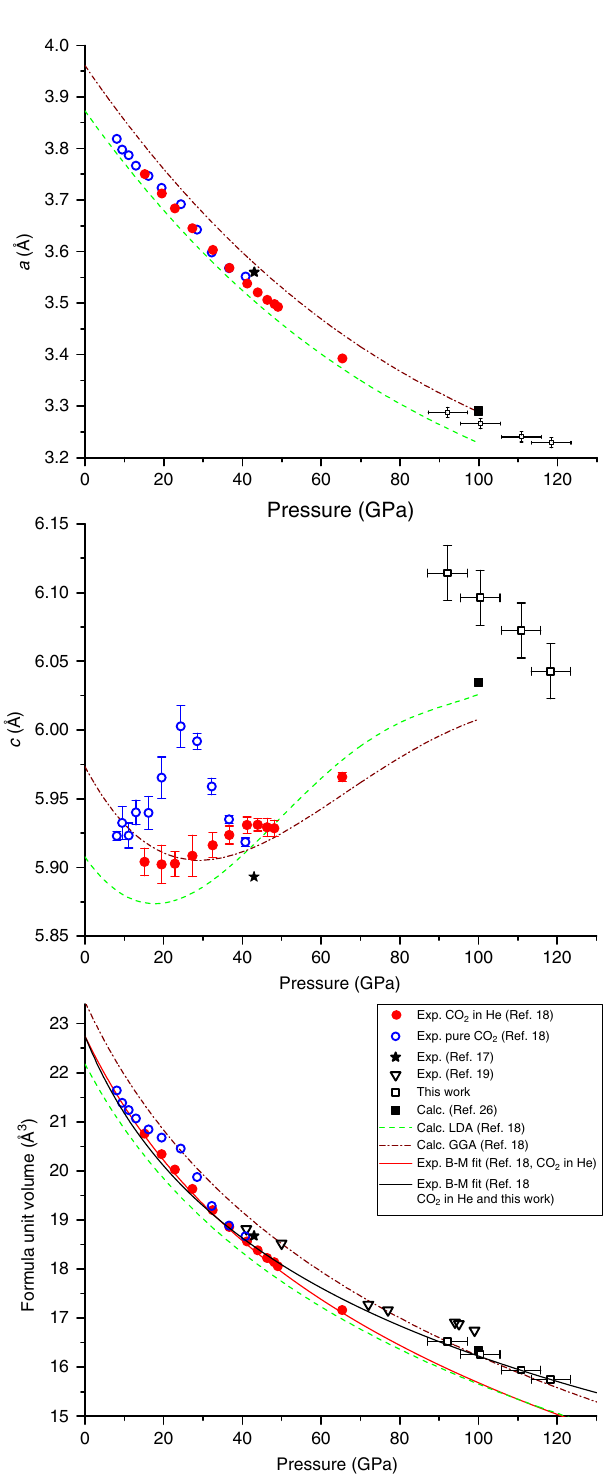
Fig. 3 Pressure dependence of lattice parameters and formula unit volume. The data for CO 2 -V phase are compared to the literature experimental (scattered points) and theory data (dashed lines, cf. the inset). The fi tted equations of states are indicated by solid lines. The experimental points determined in this work are presented with the bidirectional error bars, representing the uncertainties of lattice parameters and volume determined as obtained from the pro fi le fi tting, and ± 5 GPa uncertainty of pressure determination (see Methods section)